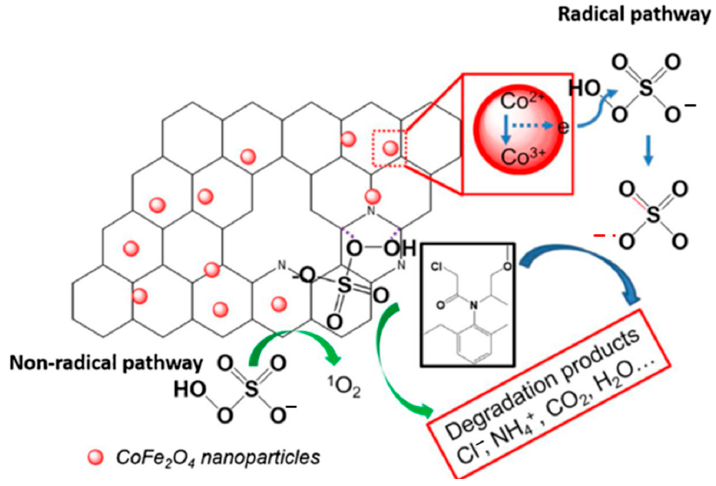
Figure 5. Mechanism of PMS activation by MNBC 800 and MET degradation [34], copyright 2019, Elsevier.